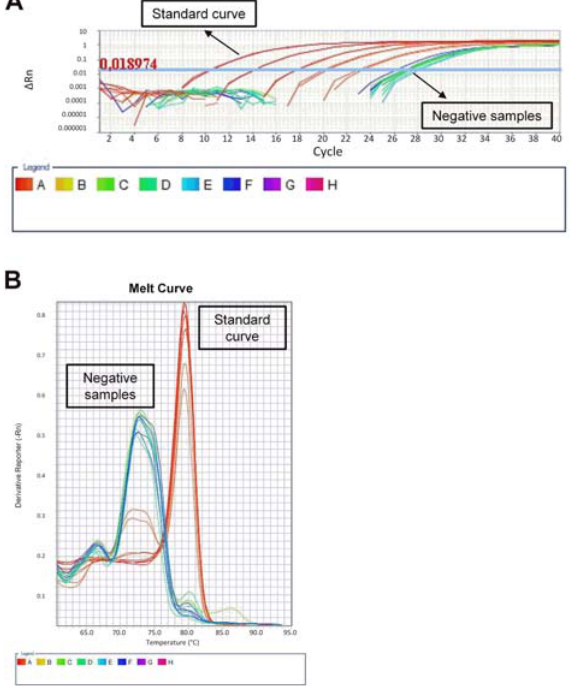
Figure 5. Analysis of shell fi sh samples for norovirus (NoV) contamination. A , Shell fi sh samples were processed and tested for NoV contamination by real-time RT-PCR along with positive and negative controls. B , Melt curve analysis to discriminate between NoV positive and negative samples. A-H: positions of samples on PCR